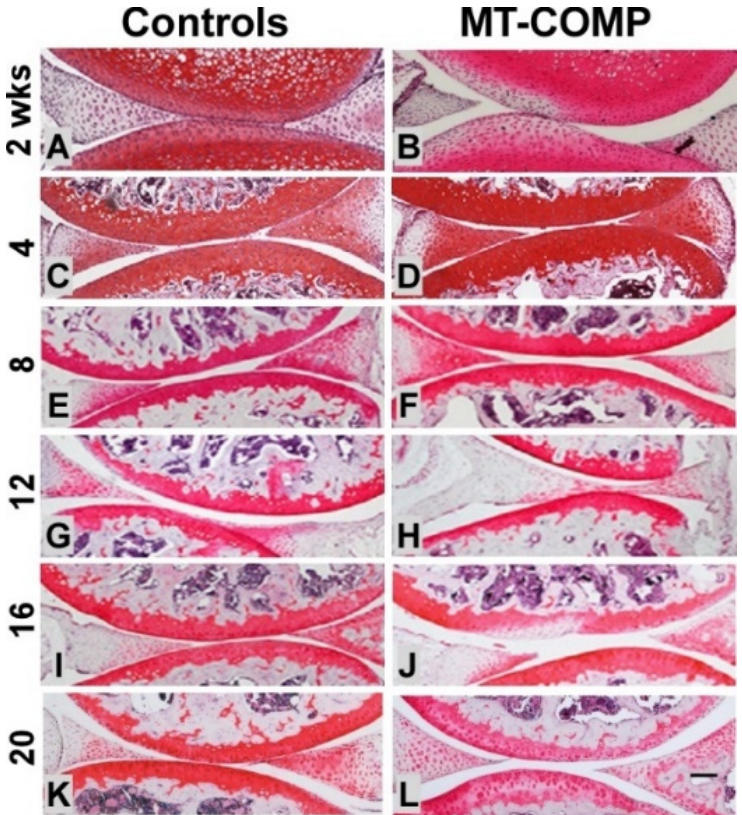
Figure 4. Reduced proteoglycans in MT-COMP mice by 16 weeks. All mice were administered DOX from birth to collection at 2, 4, 8, 12, 16, and 20 weeks. Safranin O staining (red/pink) of the control ( A , C , E , G , I , K ) and MT-COMP ( B , D , F , H , J , L ) at 2, 4, 8, 12, 16, and 20 weeks. An abundant and rich proteoglycan layer was found in the control articular cartilage ( A , C , E , G , I , K ). The proteoglycan layer in MT-COMP mice was similar to the controls at 4 and 8 weeks. ( D , F ) but was diminished in select areas at 16 weeks ( J ) and progressed to a more generalized loss at 20 weeks ( L ). Bar = 500 µm.